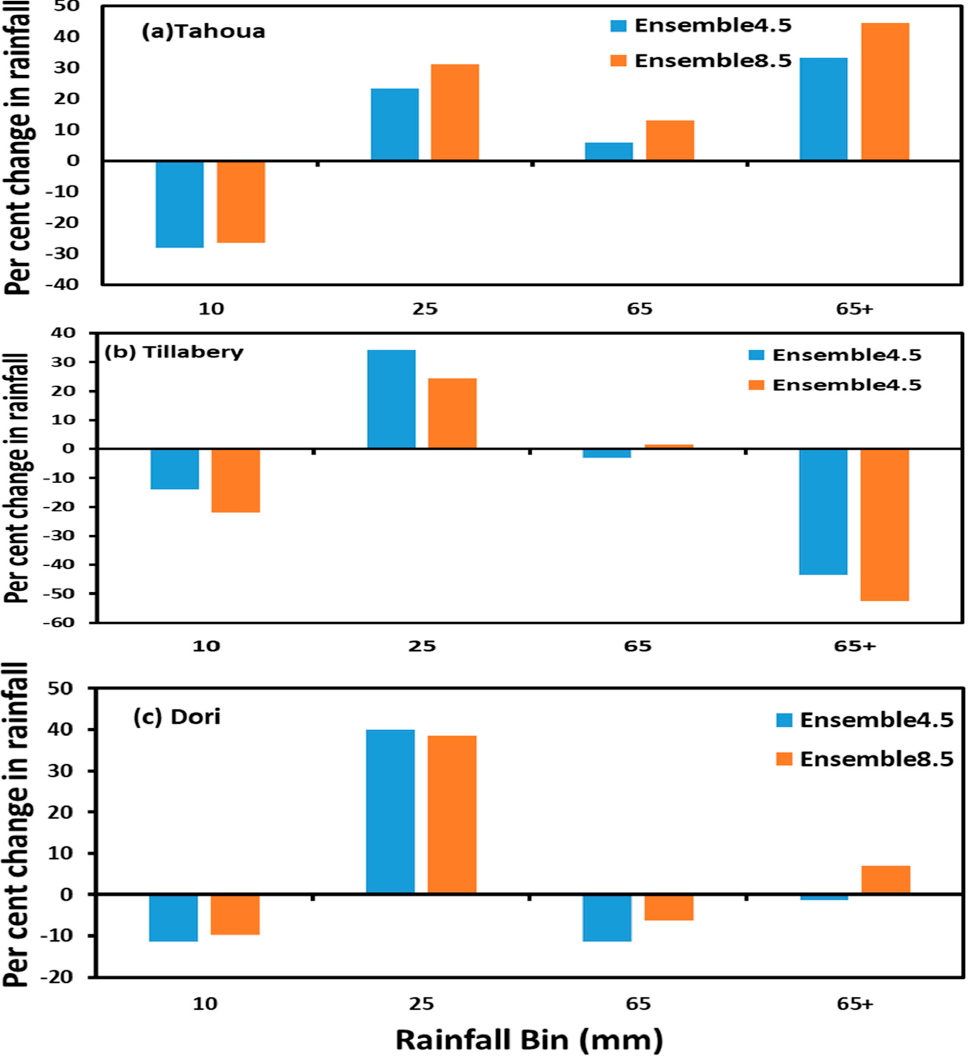
Figure 7. Sahelian (( a ) Tahoua, ( b ) Tillabery, and ( c ) Dori) average ensemble change in the frequency of rainfall at different intensities of rainfall events for the future (2021/2025–2050) relative to the baseline (1976/1980–2005).